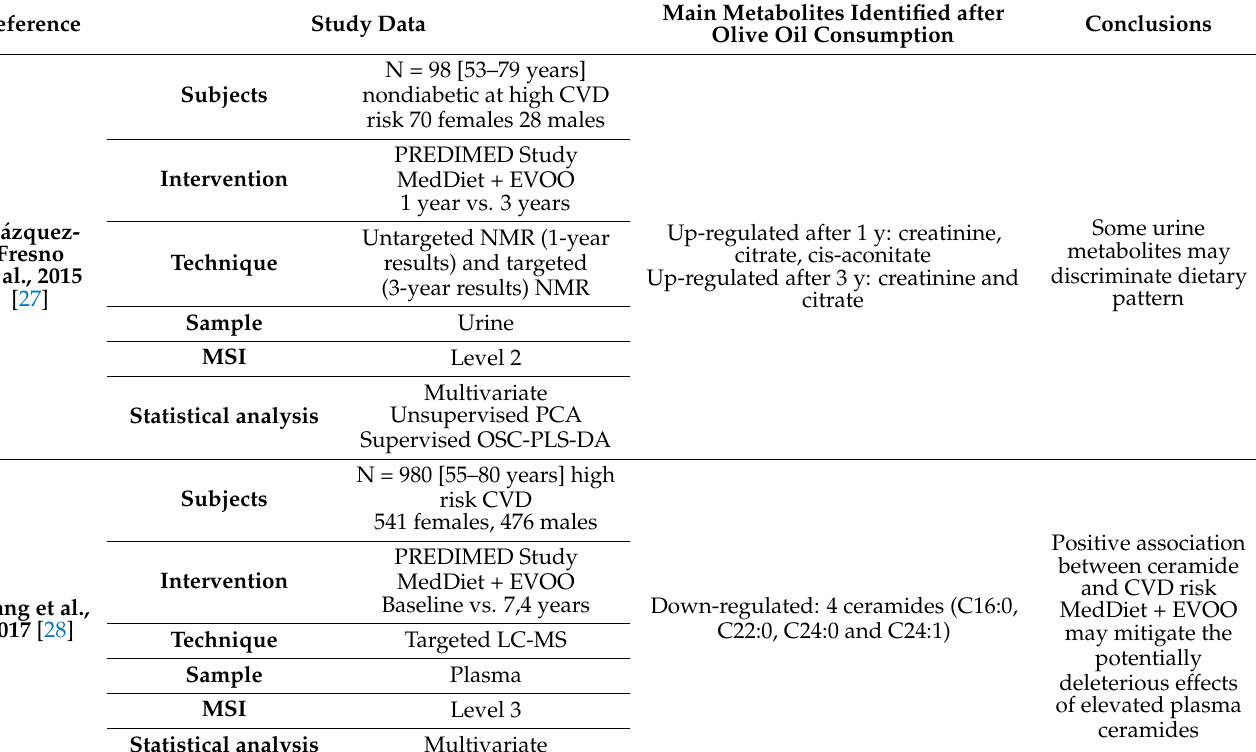
Table 1. Results of the main human metabolomics studies. Main Metabolites Identified after Olive Oil Consumption